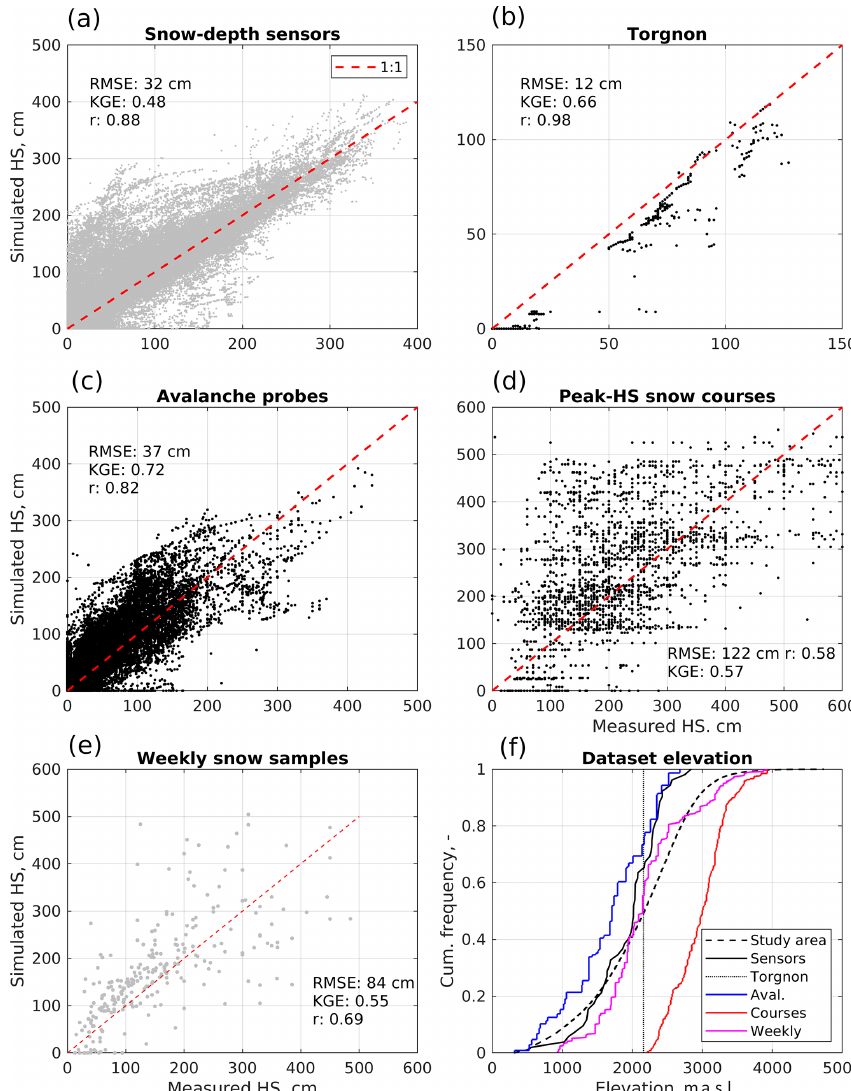
Figure 5. Performance of S3M in simulating point snow depth, as measured by continuous-time snow-depth sensors (a) , the snow-depth sensor at the intensive study plot of Torgnon, and manual snow-depth measurements taken for avalanche, hydropower, and water-supply forecasting (c–e) . Because simulations were carried out in assimilation mode, and assimilated maps indirectly involved snow-depth sensors and weekly snow samples; performances for these datasets are reported only for reference. Panel (f) shows the elevation distribution of each dataset and of the Aosta Valley for context. RMSE is root mean square error, KGE is the Kling–Gupta efficiency (Kling et al., 2012), and r is Pearson’s correlation coefficient. The spatial resolution of snow courses (d) is much finer than that of the model (say, ∼ 60m vs. ∼ 220m, respectively), and thus a number of snow-course data were compared to the same modeling value. This explains the occurrence of sharp, horizontal lines in panel (d)